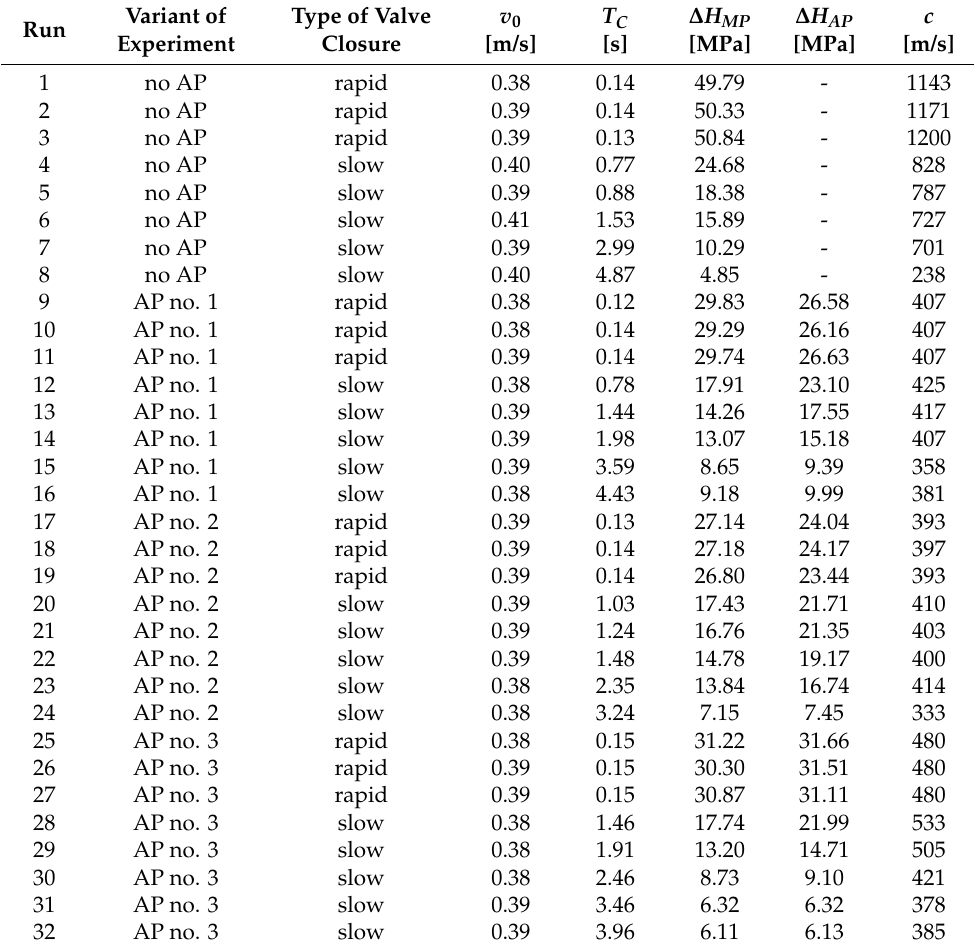
Table 2. Data from experimental